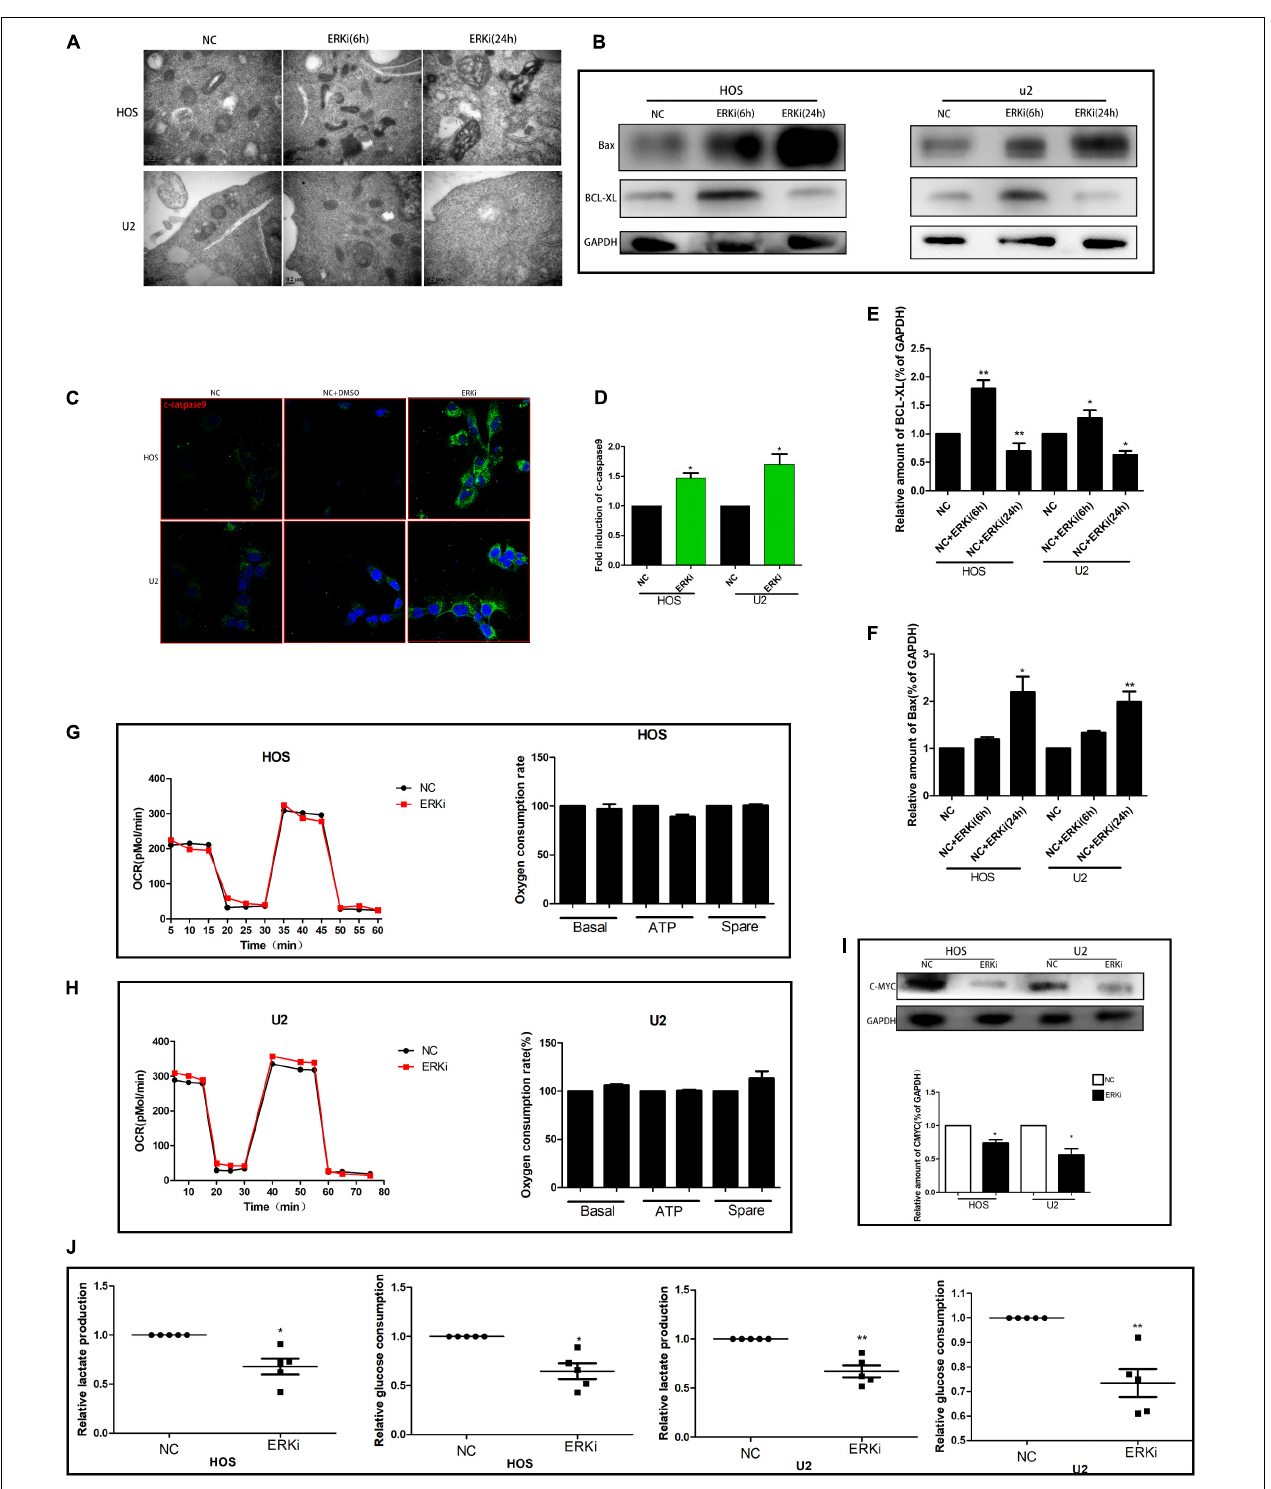
FIGURE 4 | ERK inhibition promotes apoptosis and regulates aerobic glycolysis in OS cells. (A) TEM images of ERKi-treated OS cells after 6 h and 24 h of treatment (black arrows). (B) Protein expression of Bax and BCL-XL after treatment with ERKi; GAPDH was used as the loading control and for band density normalization. (C,D) Immunofluorescence staining of c-caspase9 after 24 h of treatment with ERKi. (E,F) Optical density of Bax and BCL-XL proteins. (G,H) Diagram of OCR results obtained by OROBOROS Oxygraph-2k. (I) Western blotting and densitometric quantification. (J) Glucose uptake and production of lactic acid in OS cell lines in different groups ( n = 5 per group; ** p < 0.01 versus NC group; * p < 0.05 versus NC group).